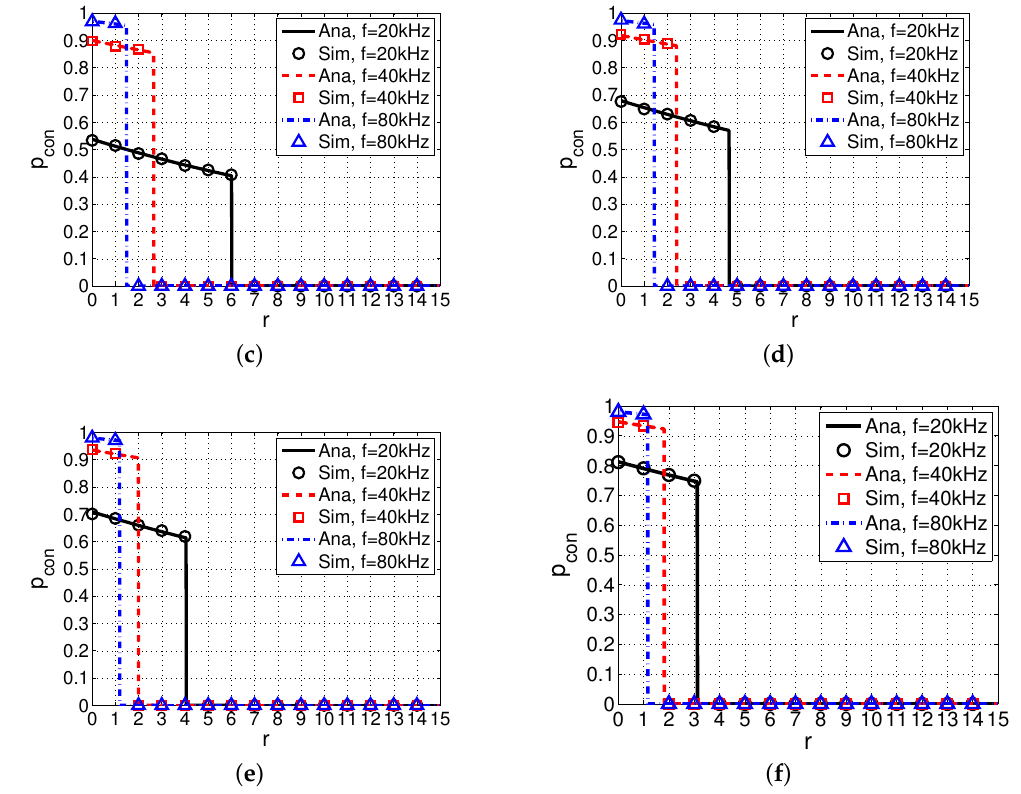
Figure 5. Probability of connection p con versus distance r with different spreading factor k and wind speed w . System parameters are set as P p = 110 dB, P s = 100 dB, λ p = 0.003, s = 1, δ s = 20 dB, and δ d = 20 dB. ( a ) k = 1, w = 0 m/s; ( b ) k = 2, w = 0 m/s; ( c ) k = 1, w = 10 m/s; ( d ) k = 2, w = 10 m/s; ( e ) k = 1, w = 20 m/s; ( f ) k = 2, w = 20 m/s.